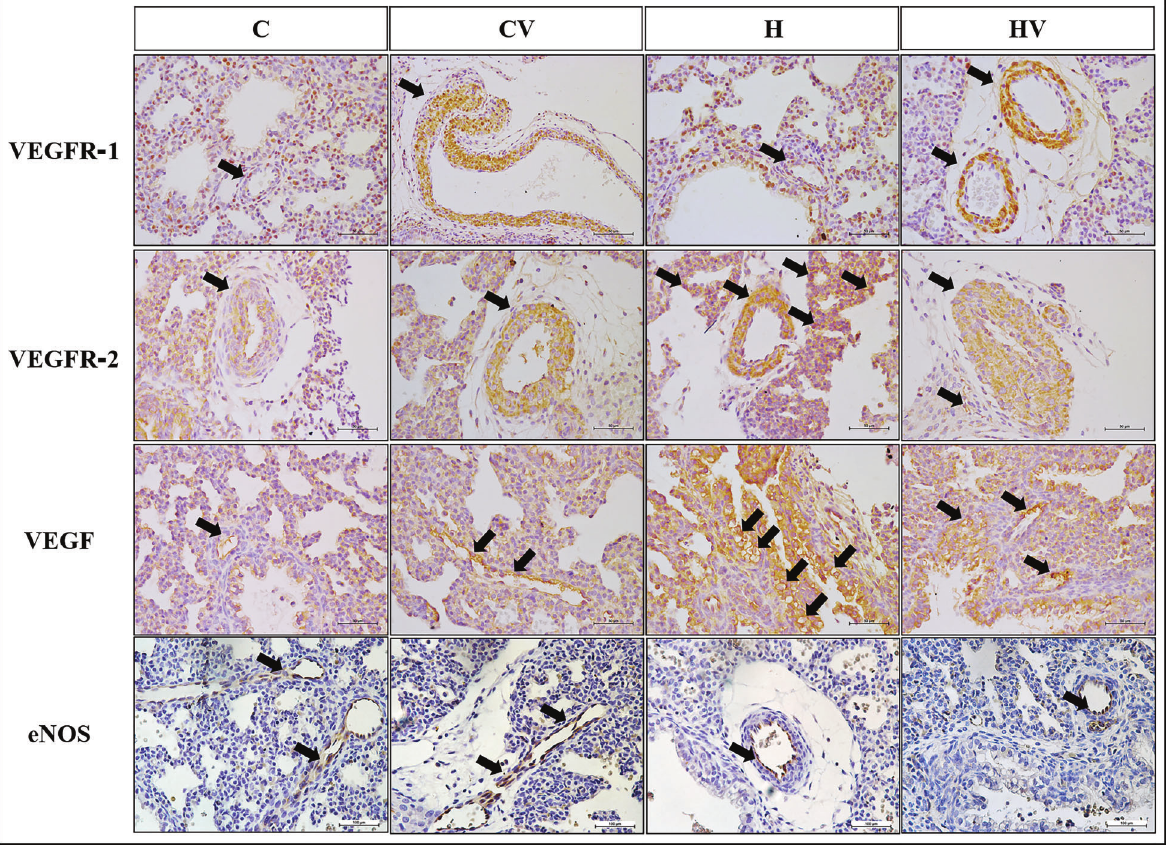
Figure 3. Immunostaining of vascular endothelial growth factors (VEGF)R-1, VEGFR-2, VEGF and endothelial NO synthase (eNOS) in the lung. C: control; CV: control submitted to mechanical ventilation. H: hypoxia. HV: hypoxia submitted to mechanical ventilation. Black arrows: local staining. Magni fi cation, 200 (cid:1) ; bar, 100 m